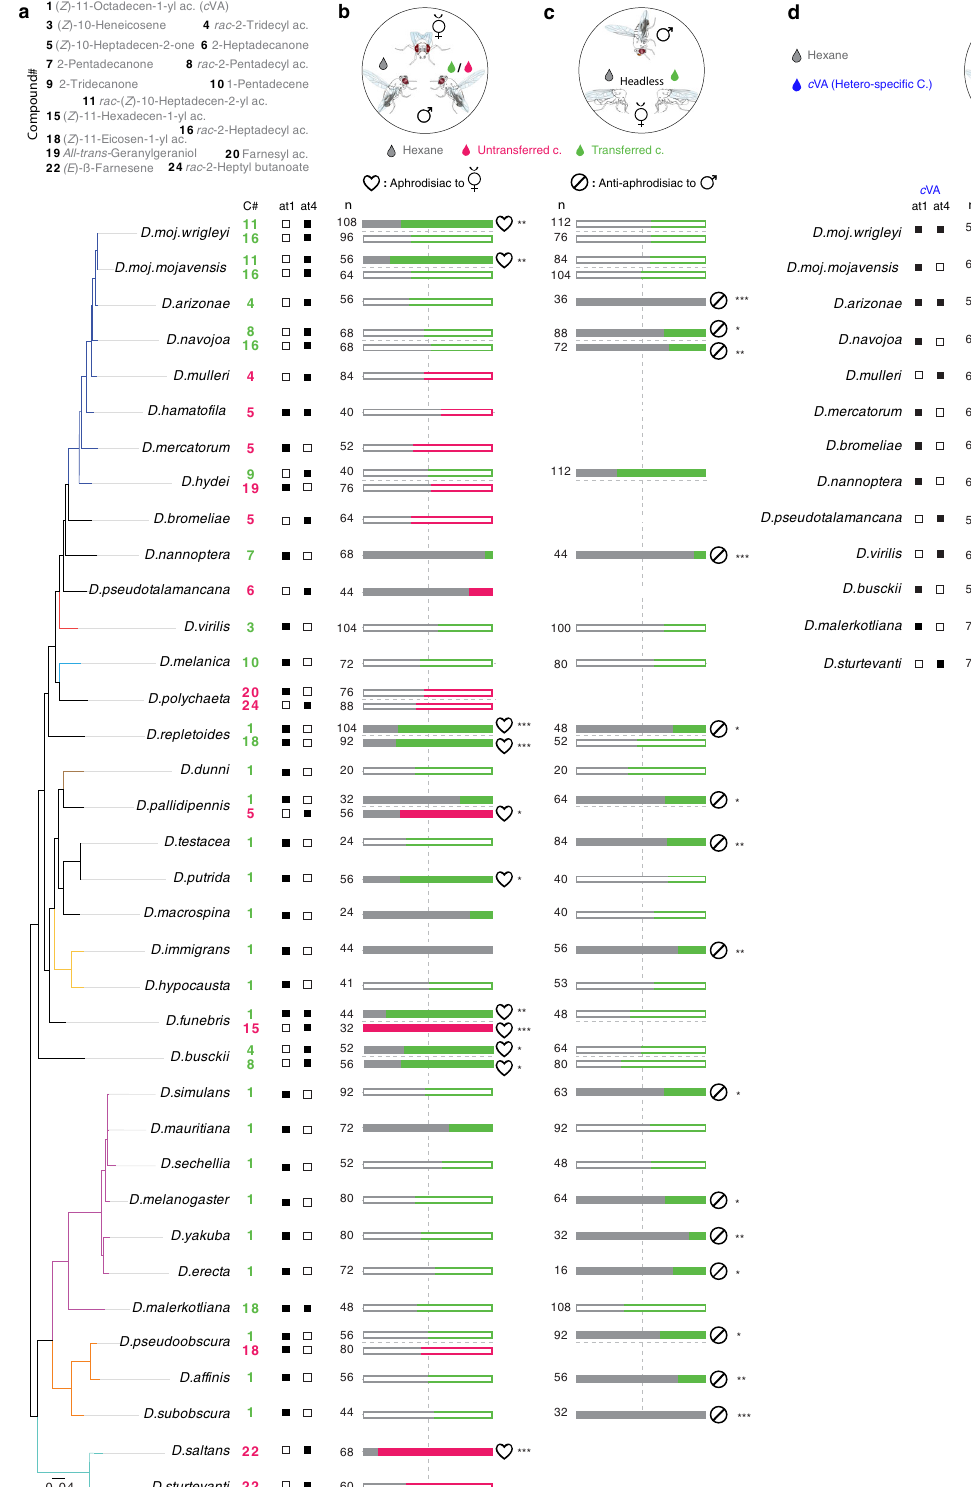
they rely on visual cues during sexual communication 76,77 . Of note, many of the sex-speci fi c compounds exist across many species in different groups, indicating that the modi fi cation of a sexual chemical trait has occurred independently multiple times during the evolution of drosophilid fl ies (Fig. 2b; Supplementary Fig. 2B). For example, c VA, ( Z )-11-eicosen-1-yl acetate, and palmityl acetate are present in 34, 13, and 12 species that